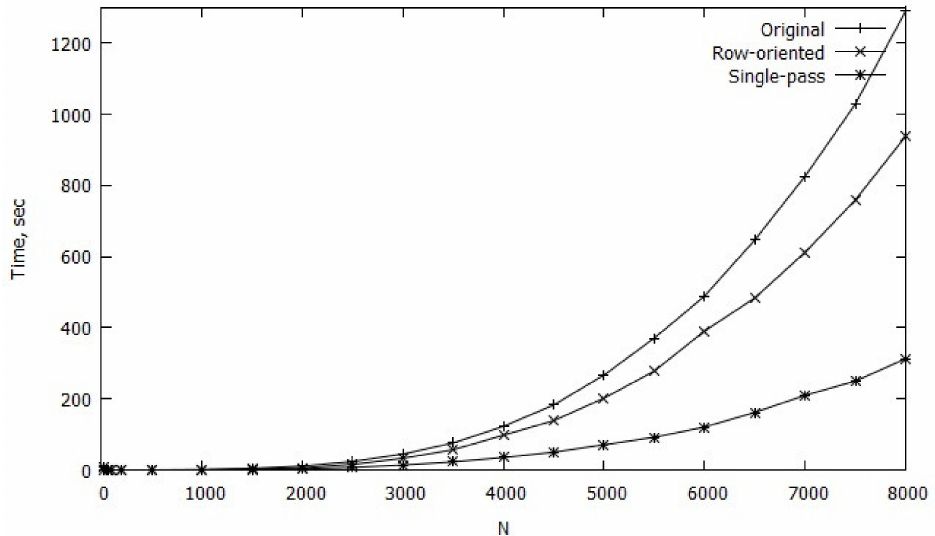
Figure 5. Dependence of the software execution time on the problem dimension.